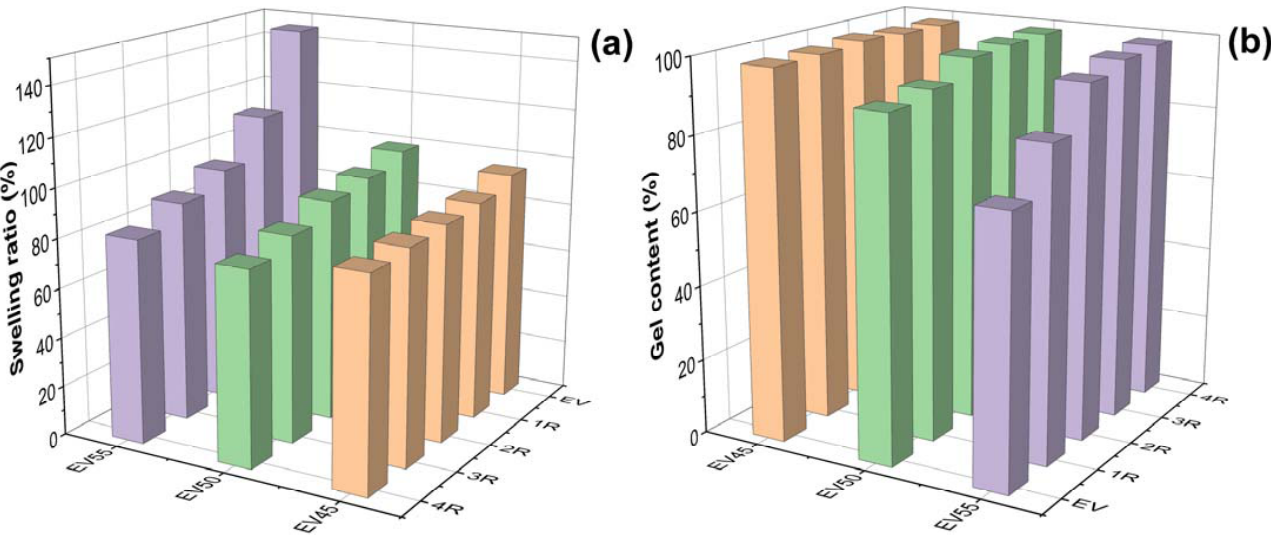
Figure 6. ( a ) Swelling ratios and ( b ) gel contents of the original and recycled epoxy vitrimers after immersing in toluene for 48 h at room